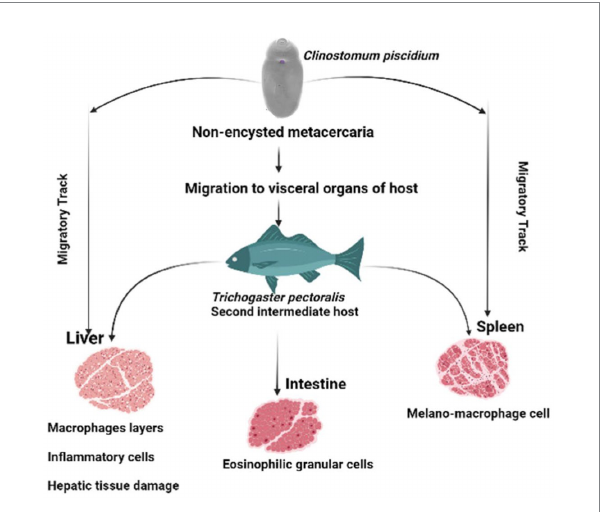
FIGURE 4 Schematic diagram of the pathological effects of Clinostomum piscidium on Trichogaster